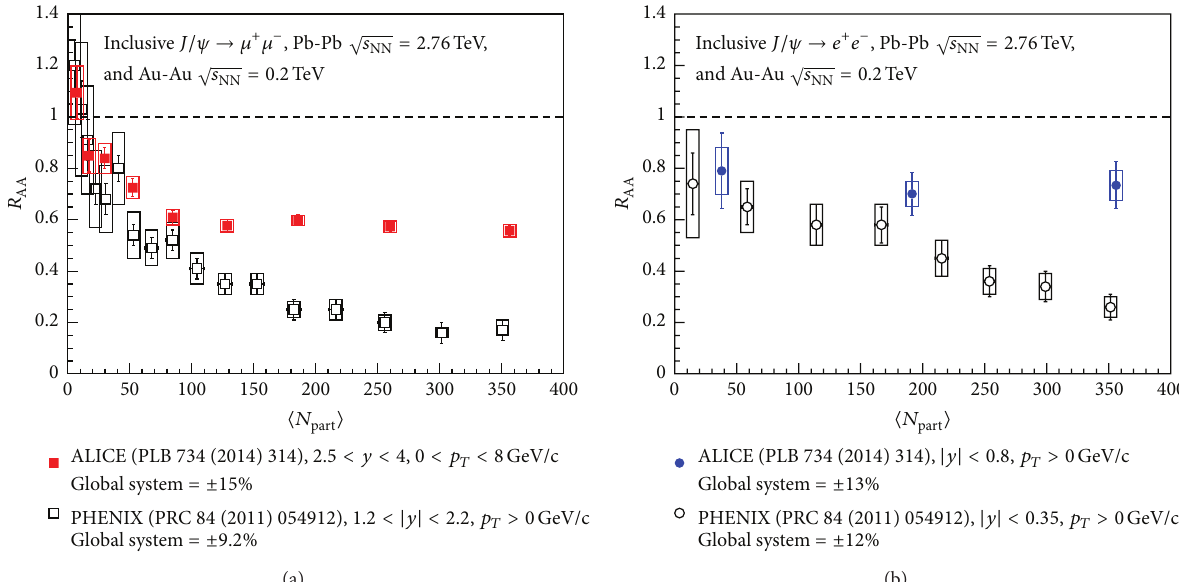
Figure 3: Comparison of 𝑅 AA results, obtained by PHENIX and ALICE experiments. The two panels show the data at forward rapidity (a) and midrapidity (b).